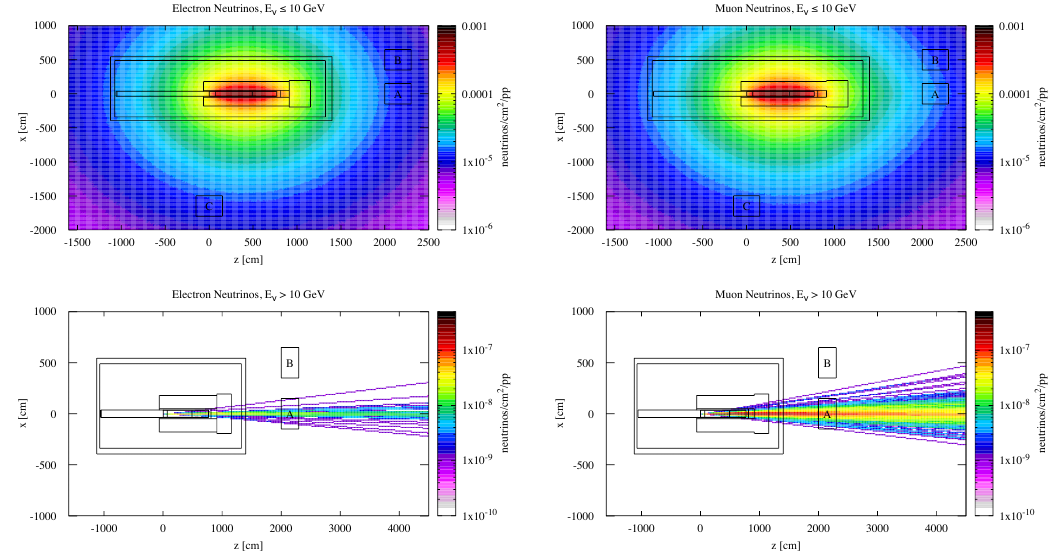
Figure 10. Neutrino fluence in cm − 2 per primary proton for E ν < 10 GeV (top) and E ν ≥ 10 GeV (bottom) for ν e (left) and ν µ (right). The isotropic component comes from mesons decaying at rest in the beam dump, while high energy neutrinos are mostly in the forward